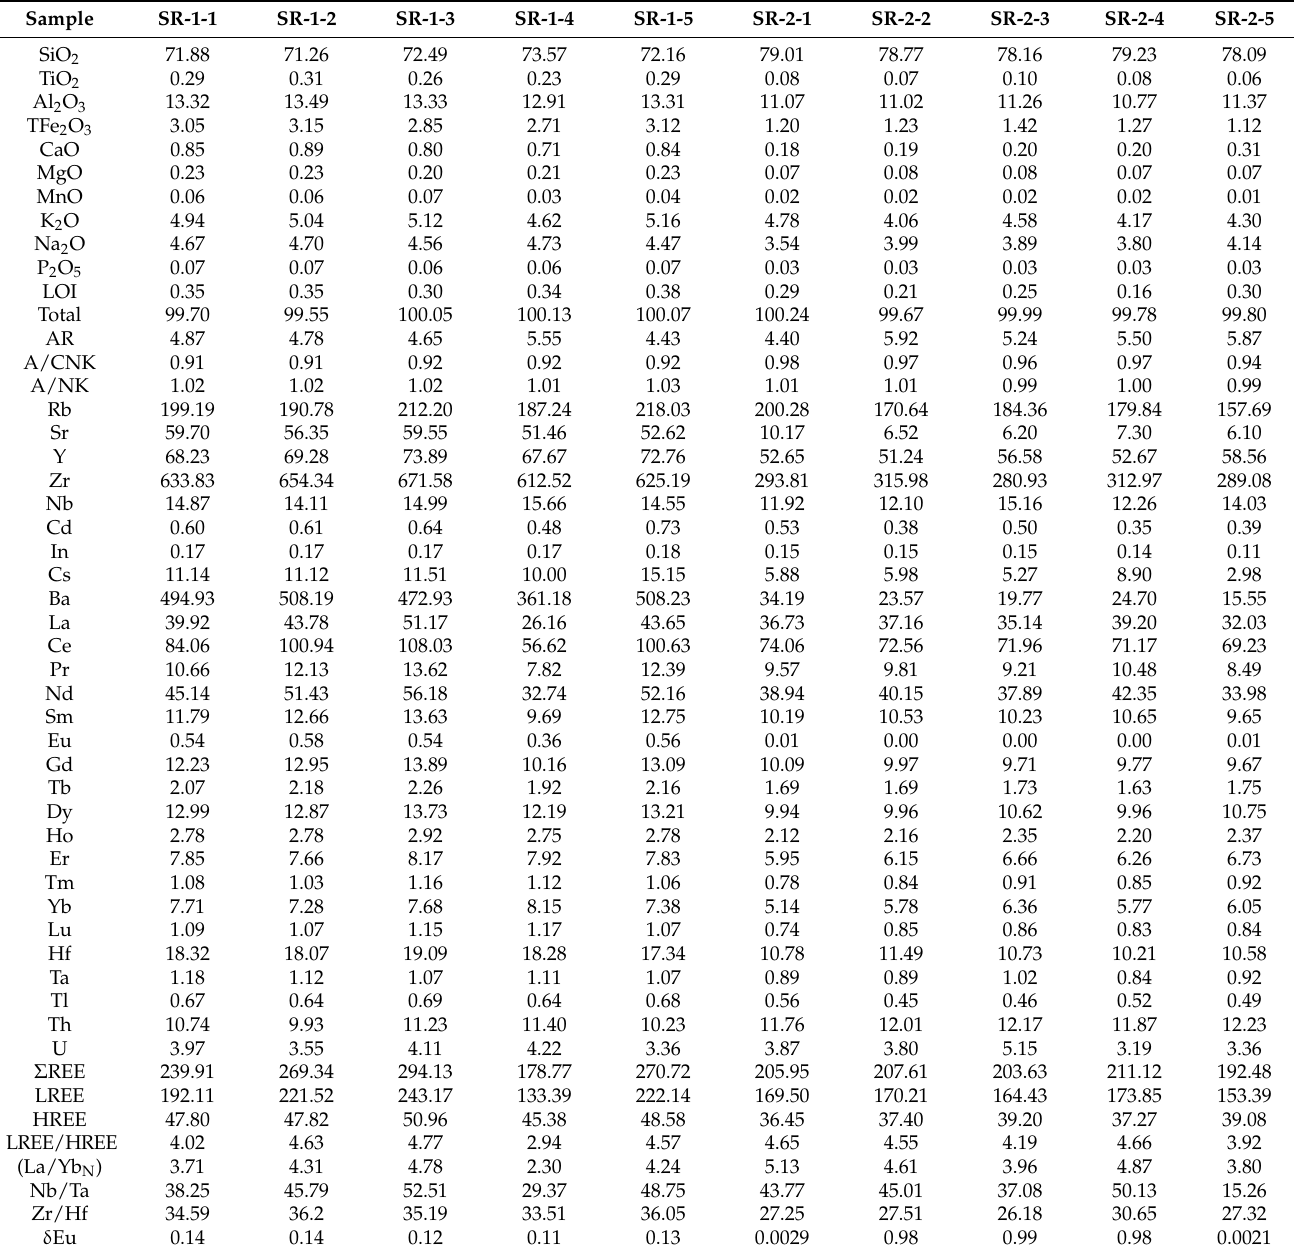
Table 1. Major (%) and trace (ppm) element compositions of the granite porphyry and the medium- fine-grained granite from the Qiushuwan